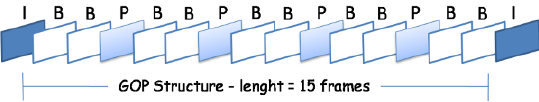
Figure 1. MPEG-2 GoP structure.